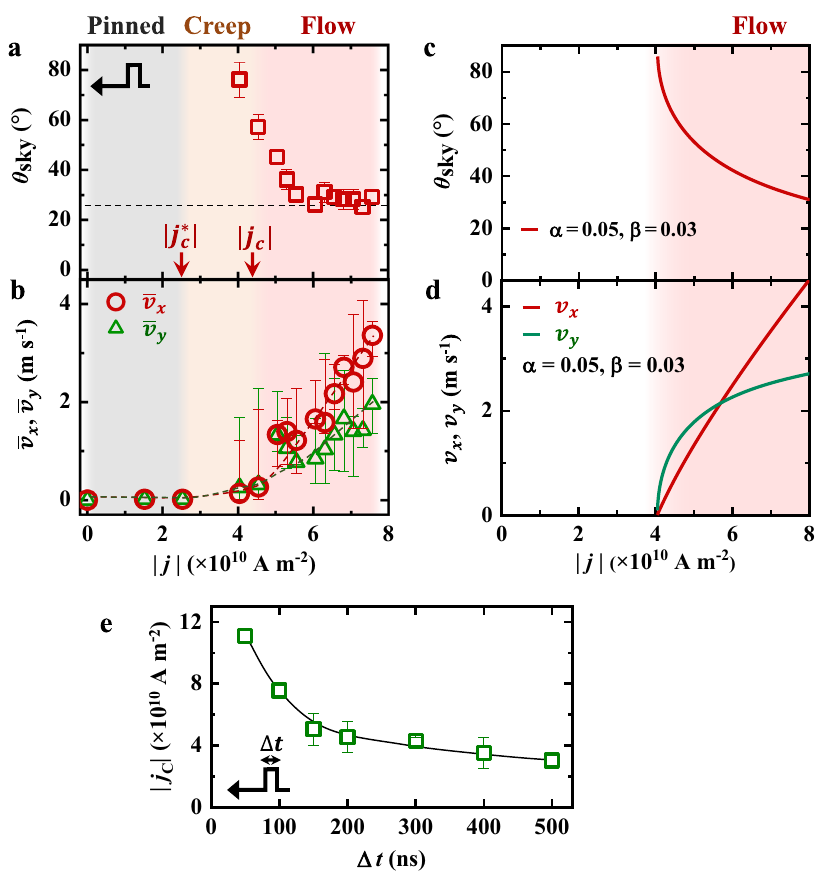
Fig. 4 Dynamic transition of single-skyrmion motion as a function of pulsed electric current. a , b Evolution of a the skyrmion Hall angle ( θ sk ) and b the average skyrmion velocities ( (cid:1) v x and (cid:1) v y ) with electric current density for 150 ns pulse duration and − 80 mT magnetic fi eld derived from L-TEM observations. The Hall angle saturates at ~26° with increasing electric current, as marked by the dashed line in ( a ). (cid:1) v x (red color) and (cid:1) v y (green color) in ( b ) are the average transverse and longitudinal velocities of the single skyrmion, respectively. The error bars in ( b ) show the maximum and minimum velocities for a single current pulse. The gray, orange, and pink regions in ( a , b ) correspond to the skyrmion-pinned regime ( j j j < j j (cid:7) C j ~2.52 × 10 10 A m − 2 ), the skyrmion creep-motion regime (2.52 × 10 10 A m − 2 < j j j < 4.54 × 10 10 A m − 2 ), and the skyrmion linear fl ow-motion regime ( j j j > j j C j ~4.54 × 10 10 A m − 2 ), respectively. c , d Calculations of j j j -dependent ( c ) Hall angle θ sk and ( d ) velocities of v x (red line) and v y (green line) with α ¼ 0.05 and β ¼ 0.03 for the j ), driving a single-skyrmion motion into the fl ow regime, as a function of the fl ow regime of skyrmion motion. e A plot of the critical current density ( j j C pulse duration 4 t